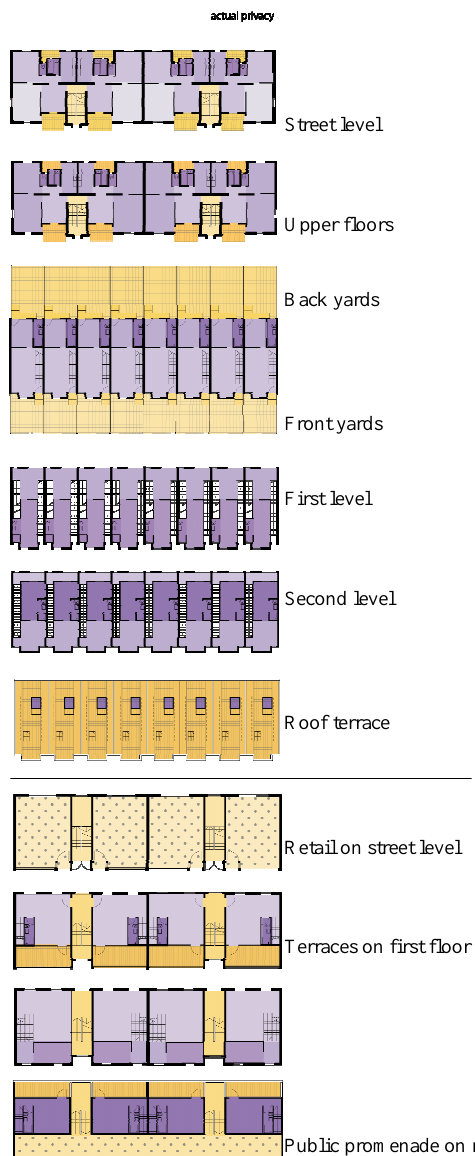
Figure 9: Privacy levels in three